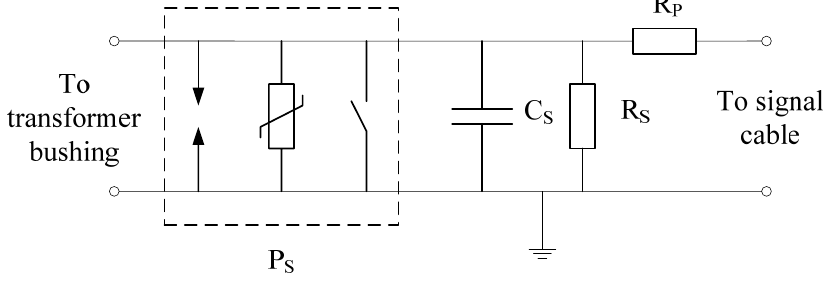
Figure 2. Simulation model of voltage sensor that mounted at the tap of transformer